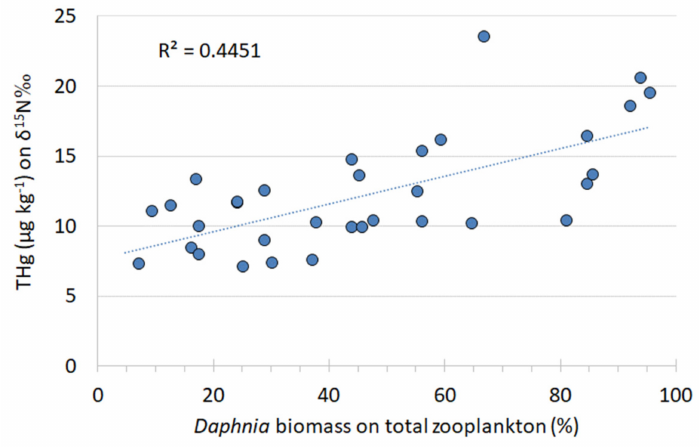
Figure 4. Relationship between the percentage of D. longispina-galeata gr. biomass relative to the total zooplankton biomass and the total mercury concentrations in zooplankton of Lake Maggiore ( ≥ 450 and ≥ 850 µ m size fractions) normalized to δ 15 N‰. Summer values were excluded (see text for